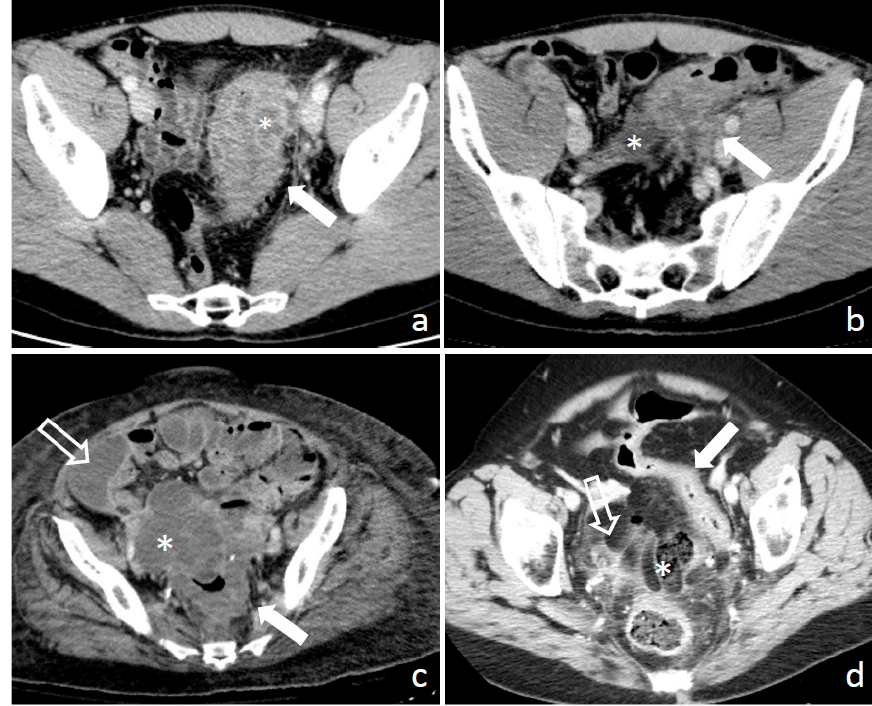
Figure 3. Modified Hinchey classification based on CT imaging: ( a ) Hinchey I—colonic wall thickening (arrow) with pericolic fat stranding and a localized abscess (*); ( b ) Hinchey II—colonic wall thickening (arrow), important fat stranding and a pelvic abscess (*); ( c ) Hinchey III—colonic wall thickening (arrow), with a pelvic abscess (*) and the presence of pus in the abdominal cavity (empty arrow) circumscribed by peritoneal thickening signs of purulent peritonitis; ( d ) Hinchey IV—colonic wall thickening (arrow) with intestinal perforation allowing feces into abdominal cavity (*) associated to fat and peritoneal stranding (empty arrow) signs of fecal peritonitis.